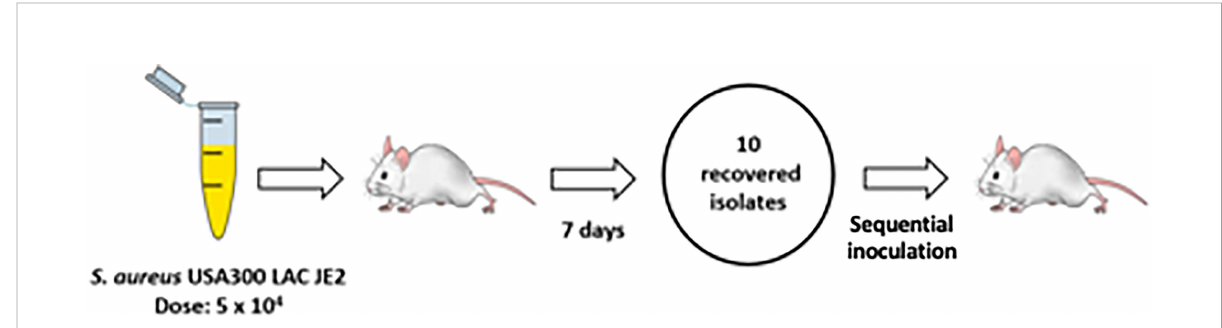
FIGURE 2 Serial passage of S. aureus in a murine nasopharyngeal colonization model. Schematic demonstration of sequential colonization of mouse nasopharynx by S. aureus USA300 LAC JE2. Three passages were performed with each lasting 7 d. An inoculum of ~5x10 4 CFU was used for the fi rst passage. For the second and third passages 10 isolates randomly collected from the previous passage were pooled and adjusted to ~5x10 4 CFU to serve as inoculum. Three mice were used per round of colonization.